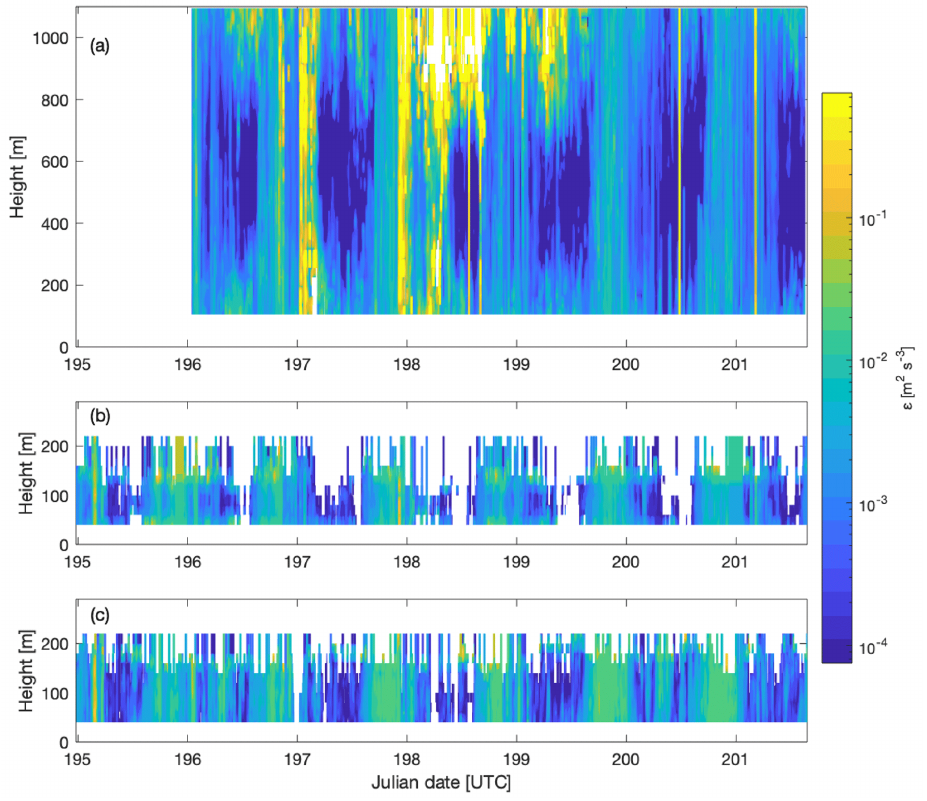
Figure 5. Time–height contours of 30min averaged turbulence dissipation rate for the Halo Streamline (a) , WindCube WC49 (b) , and WindCube WC68 (c) for the duration of the field